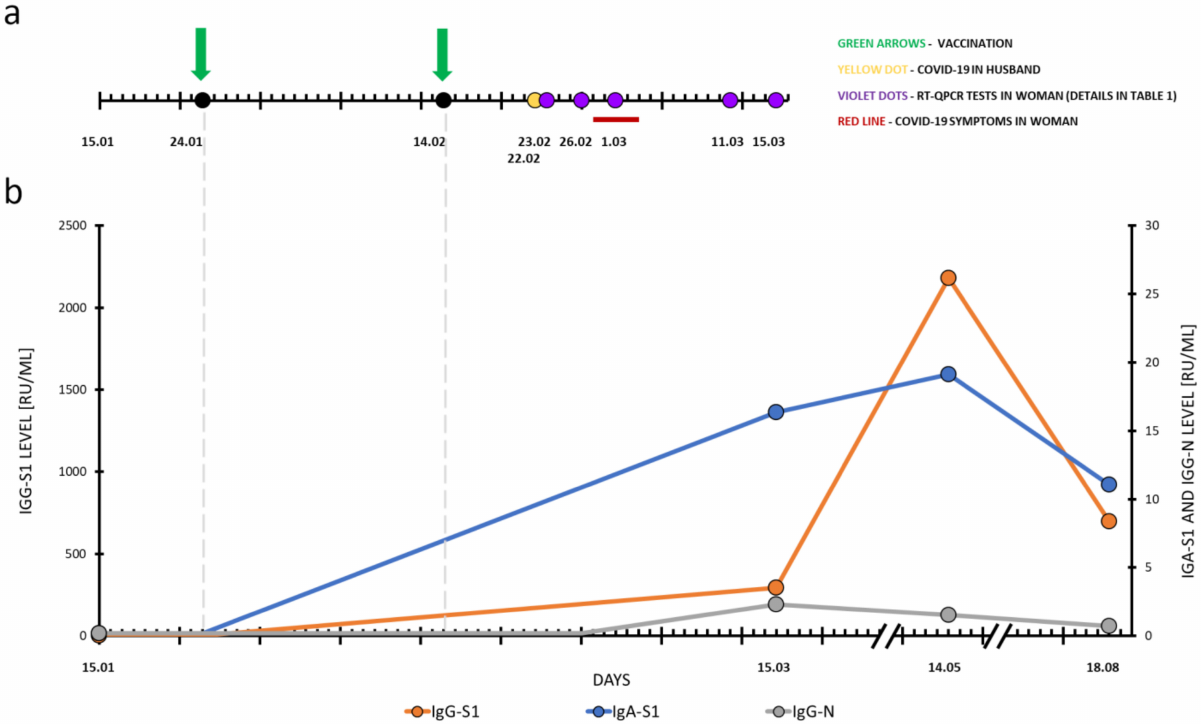
Figure 1. The timeline of the case. (a) shows the two doses of vaccine (green arrows), the identification of COVID-19 in the husband (yellow dot), the RT-qPCR tests performed in the woman (violet dots), and the duration of COVID-19 symptoms in the woman (red line). (b) shows the levels of anti-SARS-CoV-2 antibodies: IgG-S1 (orange line), IgA-s1 (blue line), IgG-N (grey